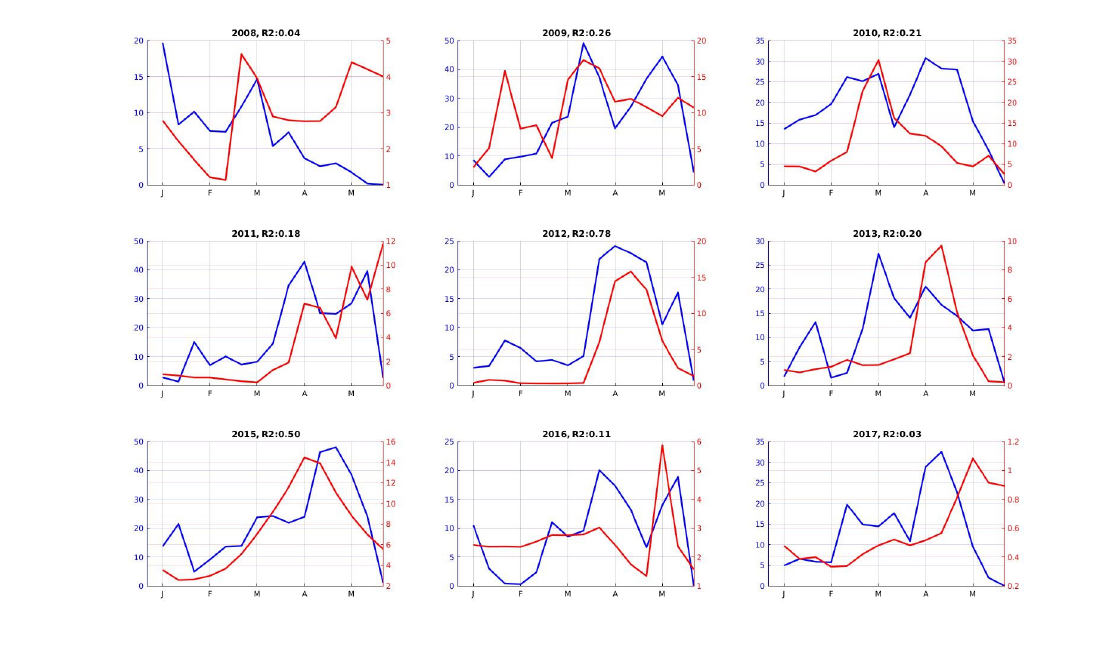
Figure 9. Time series of 10-day step simulated runoff in m 3 /s ( blue ) and observed discharge in m 3 /s ( red ) at Aghbalou between January and May from